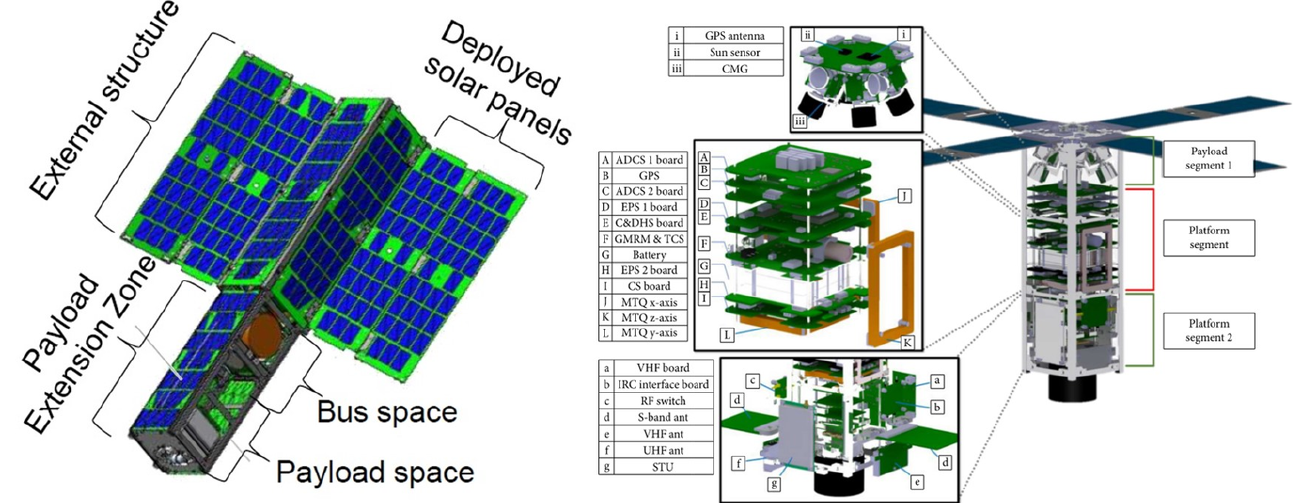
Figure 8. All-Star/THEIA CubeSat ( left ) and the KAUSAT 5 CubeSat ( right